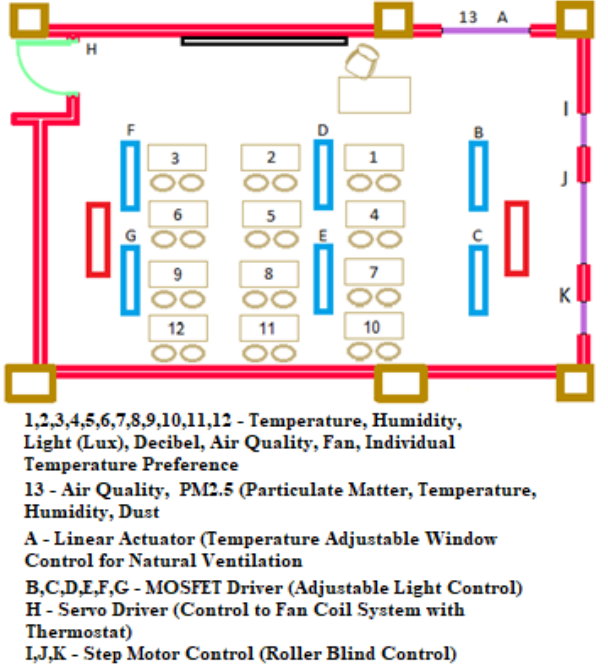
Figure 2. The layout of the SCI’s measurement and control points .